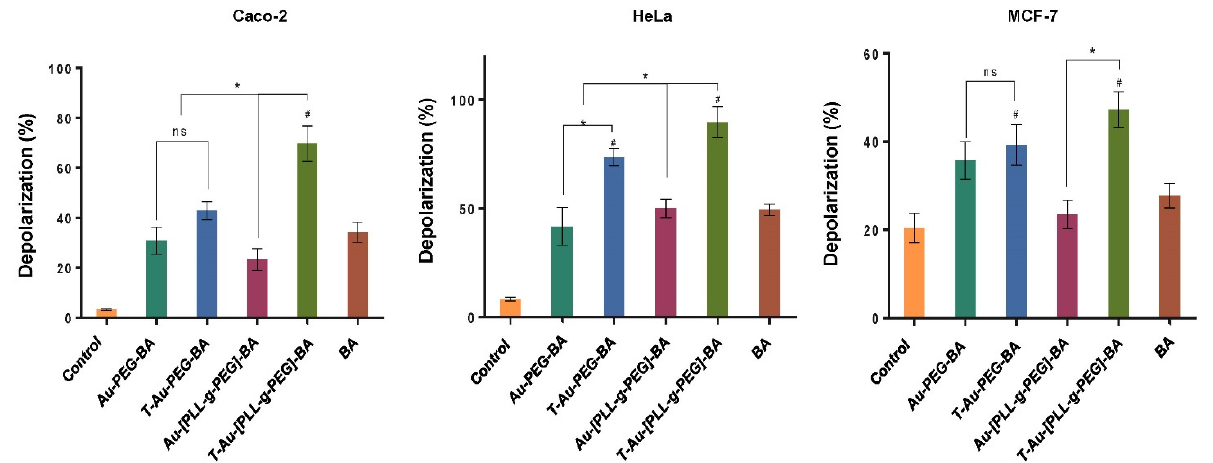
Figure 9. Graphical representation of the effect of targeted and untargeted nanocomplexes on the mitochondrial membrane potential in Caco-2, HeLa and MCF-7 cells. Data is represented as mean ± SD ( n = 3). * vs targeted or untargeted nanocomplex, # vs. free drug at p < 0.05). ns = no significant difference.